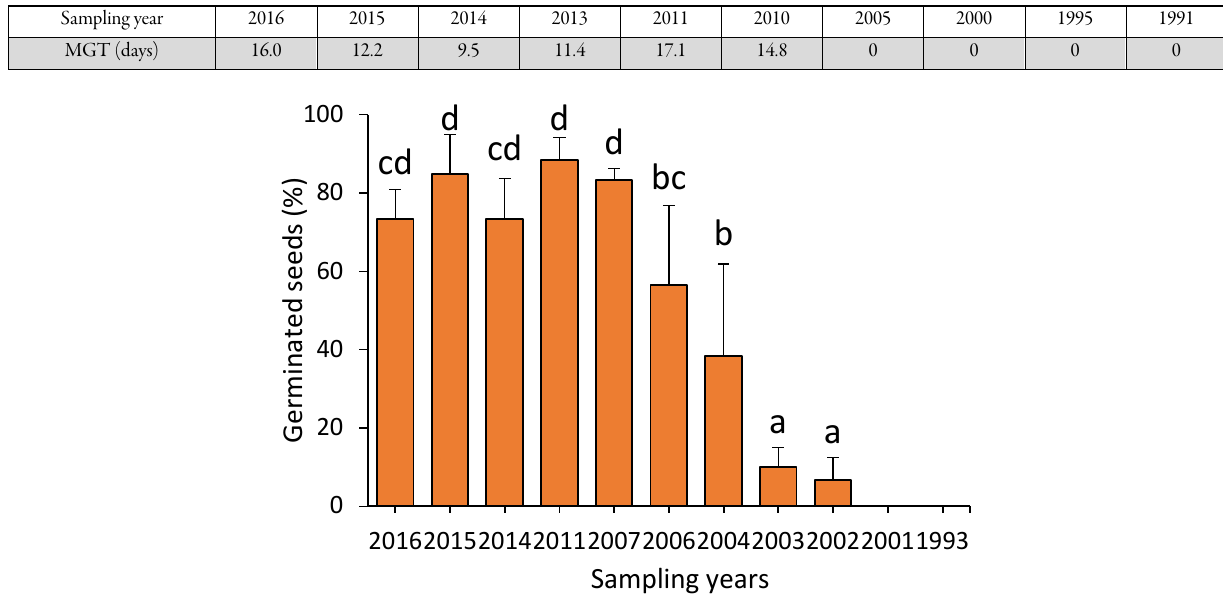
Fig. 4. Germination percentages, after 30 days of incubation, of Linum maritimum seeds sampled in the indicated years Table 3. Effect of seed storage time on germination velocity, expressed as ‘mean germination time’ (MGT), in Linum maritimum Sampling